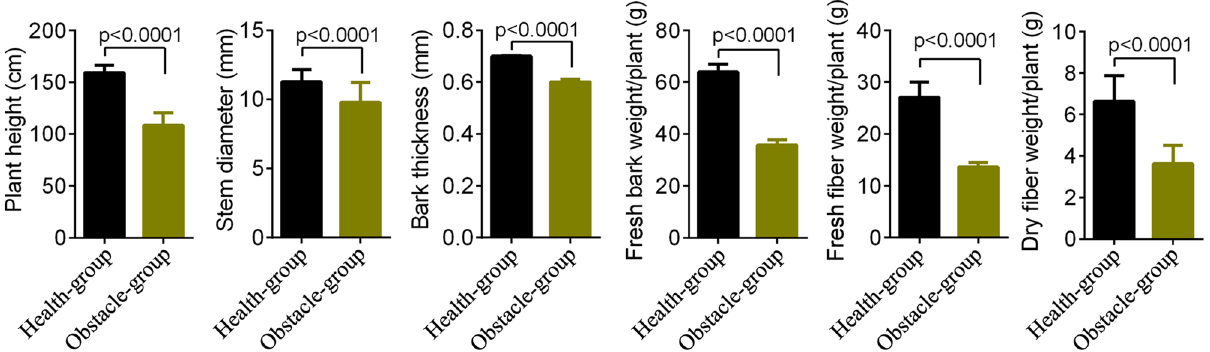
Figure 1. Changes in ramie growth and fiber traits through continuous cropping based on data collected from 30 individual plants in each group. Differences are analyzed using a